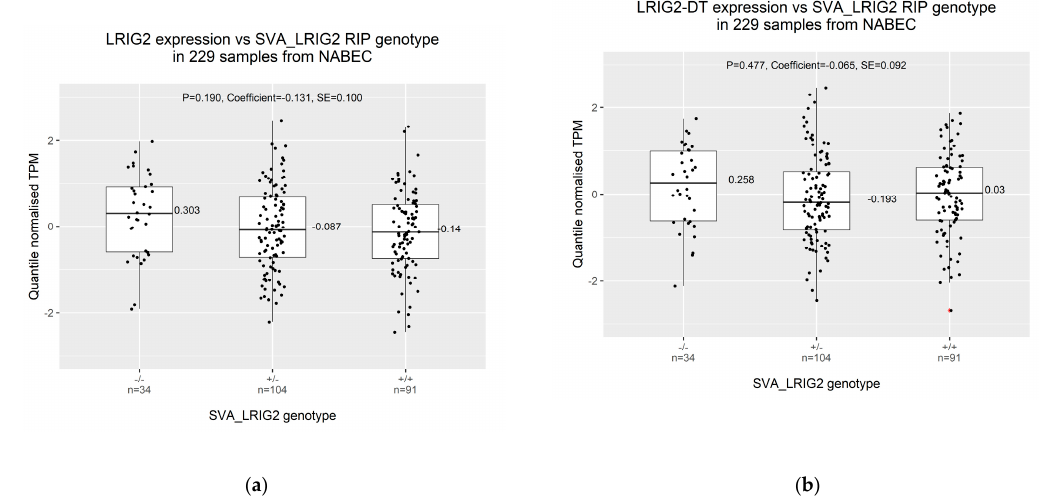
Figure 4. Frontal cortex total RNA-seq data for LRIG2 (ENSG00000198799.12) and LRIG2-DT (ENSG00000238198.2) in 229 NABEC individuals grouped by SVA_LRIG2 RIP genotype. A total of 96 genotypes were PCR validated and 145 were imputed for a total of 241 genotypes. ( a ) LRIG2 expression. ( b ) LRIG2-DT expression. RNA-seq data expressed as quantile normalised transcripts per kilobase million (TPM). Standard deviations from the mean of the normalised data are displayed on the y-axis. Linear regression analysis is shown, reporting p value of association analysis (P), model coefficient and standard error (SE). Outlier value is marked in red.